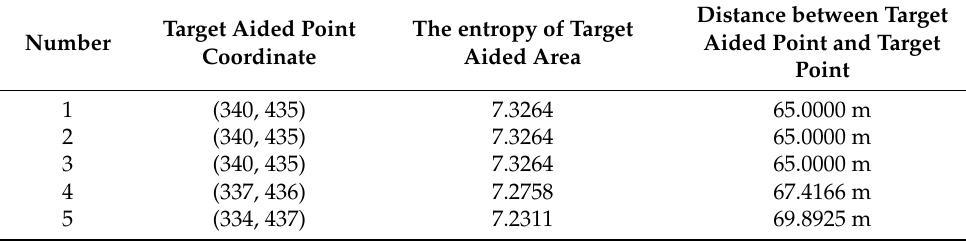
Table 5. Simulation results of target aided points search in case study